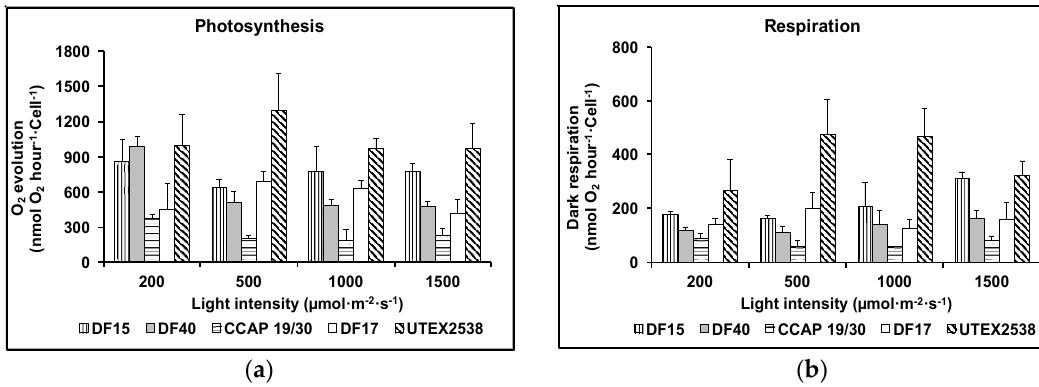
Figure 3. Photosynthesis ( a ) and respiration ( b ) of the five Dunaliella strains cultivated under four light intensities of 200, 500, 1000, and 1500 µmol·m − 2 ·s − 1 . Samples were taken at the mid log phase and all culture conditions were repeated at least in triplicates.